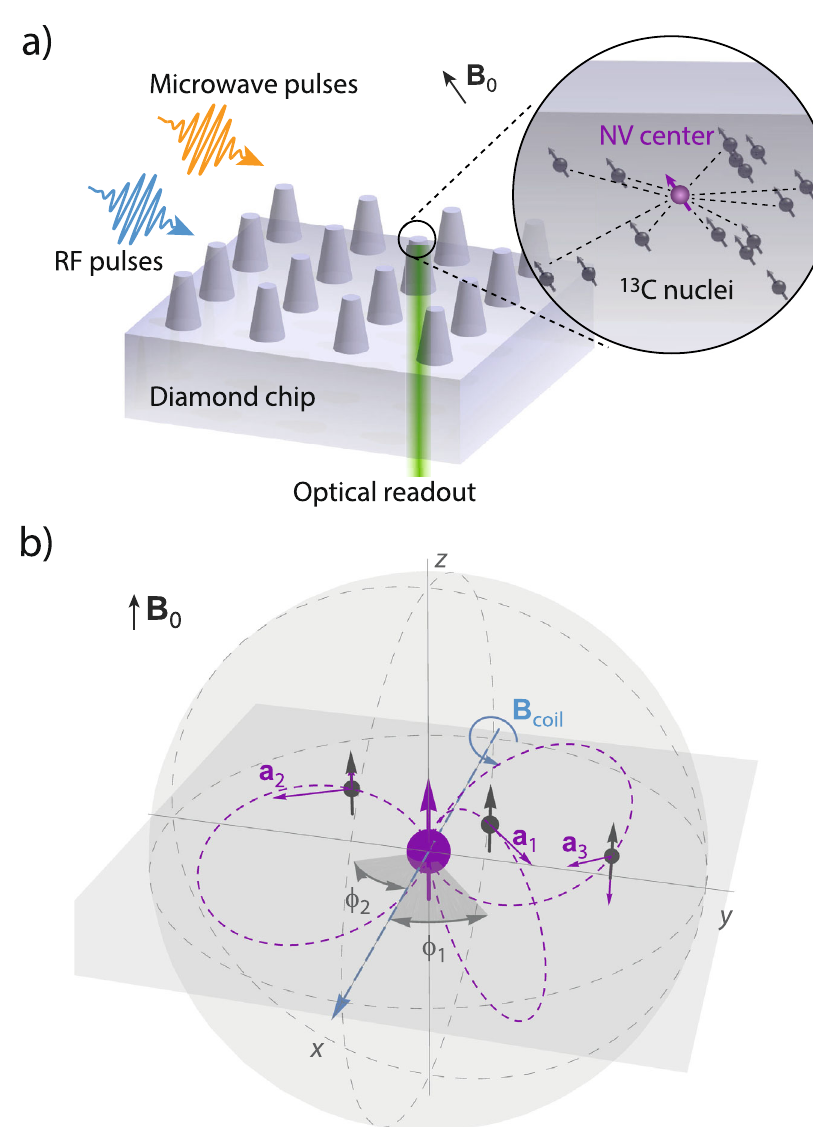
Fig. 1 Concept of the nuclear spin mapping experiment. a We detect and image nuclear spins (black) surrounding a central electronic spin (purple). In our experiments, spins are embedded in a nanostructured diamond chip, manipulated by microwave and radio-frequency (RF) pulses, and detected by optical means. b Spatial imaging is enabled through the hyper fi ne fi eld a ¼ ð a ? cos ϕ ; a ? sin ϕ ; a jj Þ , whose magnitude and direction strongly depend on the three- dimensional position r = ( r , ϑ , ϕ ). We determine the radius r and polar angle ϑ by measuring the parallel and transverse hyper fi ne components, a ∣∣ = a ⋅ e z and a ⊥ = ∣ a × e z ∣ 19,54 . The azimuth ϕ is equal to the phase of the nuclear precession 21,22 . e z is a unit vector pointing along the electronic quantization axis and B 0 ∣∣ e z is an external bias fi eld. B coil ∣∣ e x is the direction of the RF fi